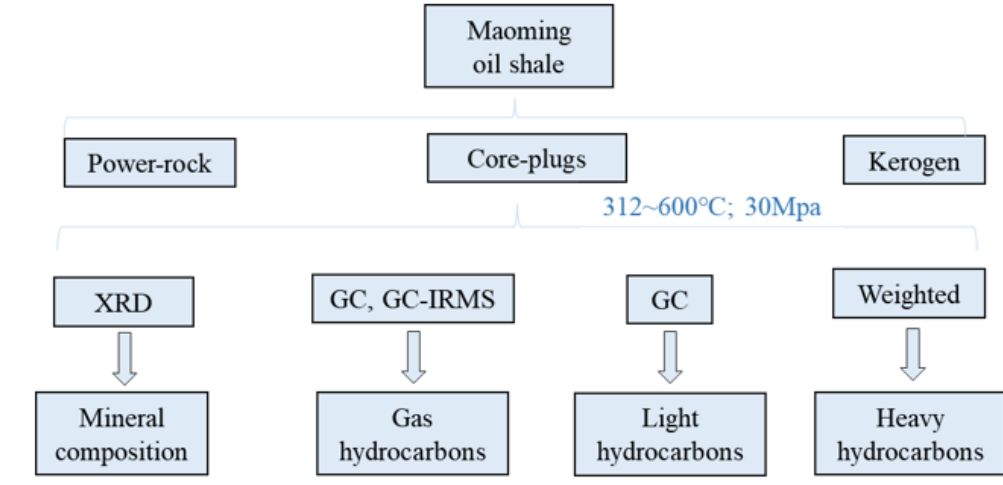
Figure 2. Basic experimental procedure of this study. Table 1. Basic geochemical data and mineral composition of kerogen, powdered rock and core plugs of Maoming oil